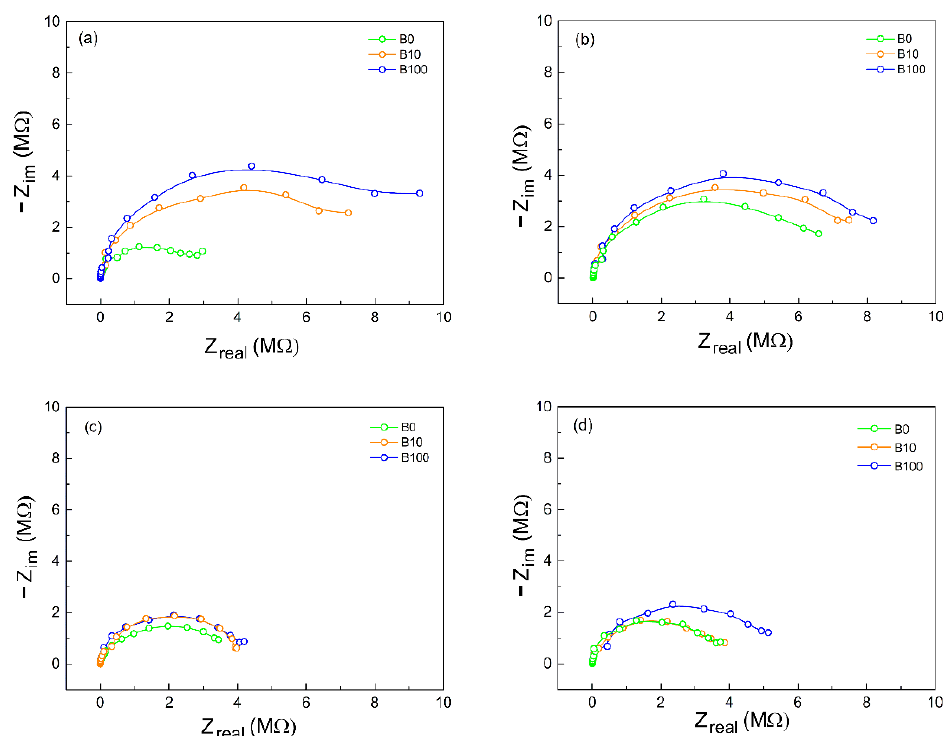
Figure 11. Nyquist diagrams of the fuel samples, using the electrodes: ( a ) Ba1810, ( b ) Ba1820, ( c ) Ba1830, and ( d ) Ba1850.